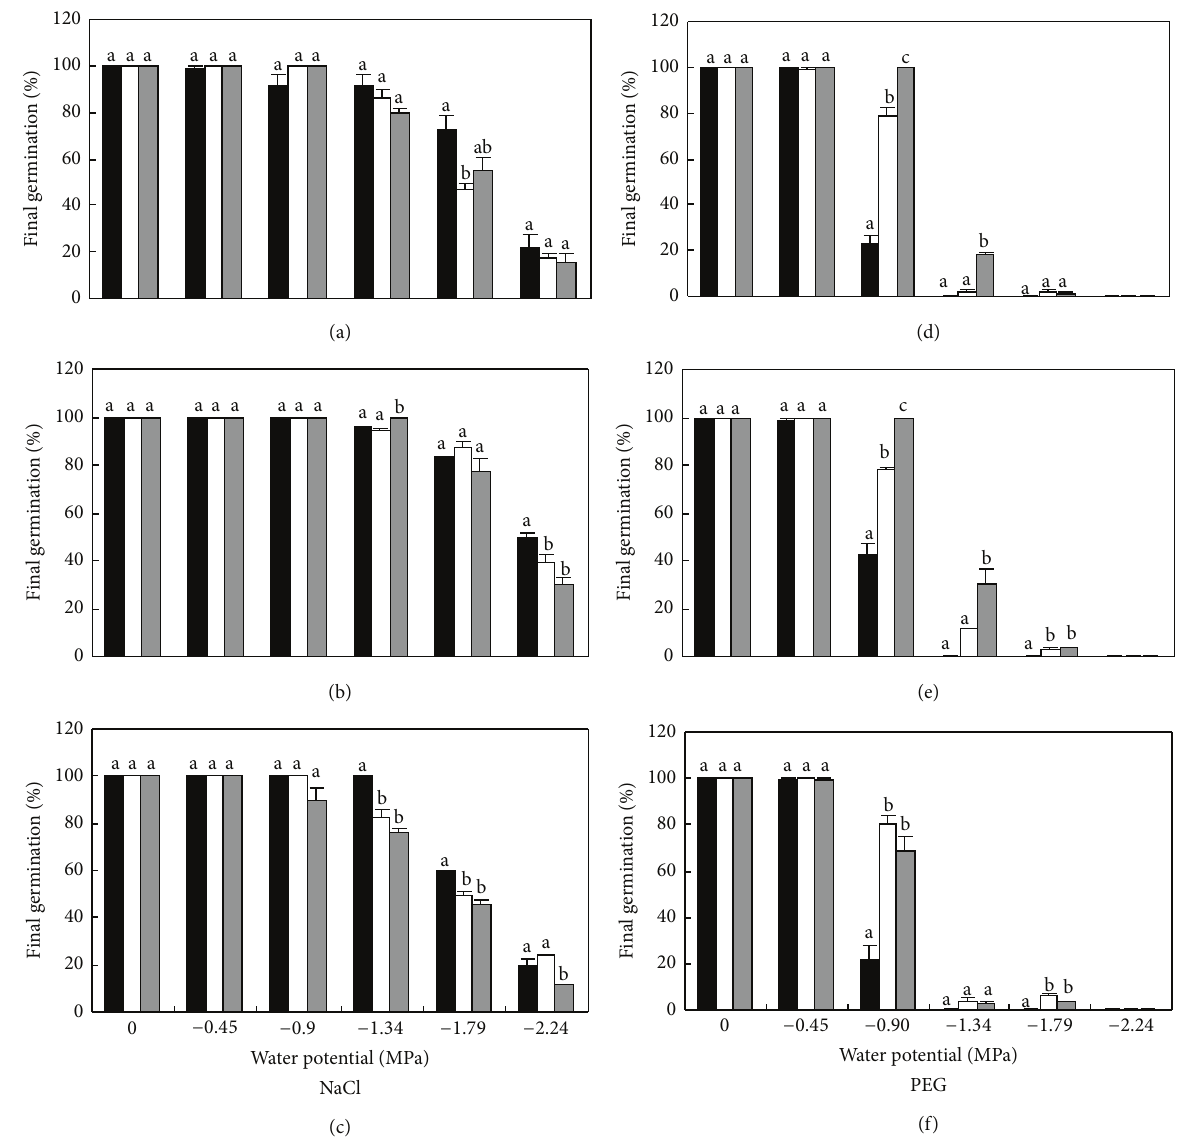
Figure4:FinalgerminationpercentageofDX(aandd),SDM(bande),andLK(candf)inNaClandPEGsolutionsatalternatingtemperature regimes. 10:20 (black bar), 15: 25 (white bar), and 20 :30 ∘ C (grey bar).